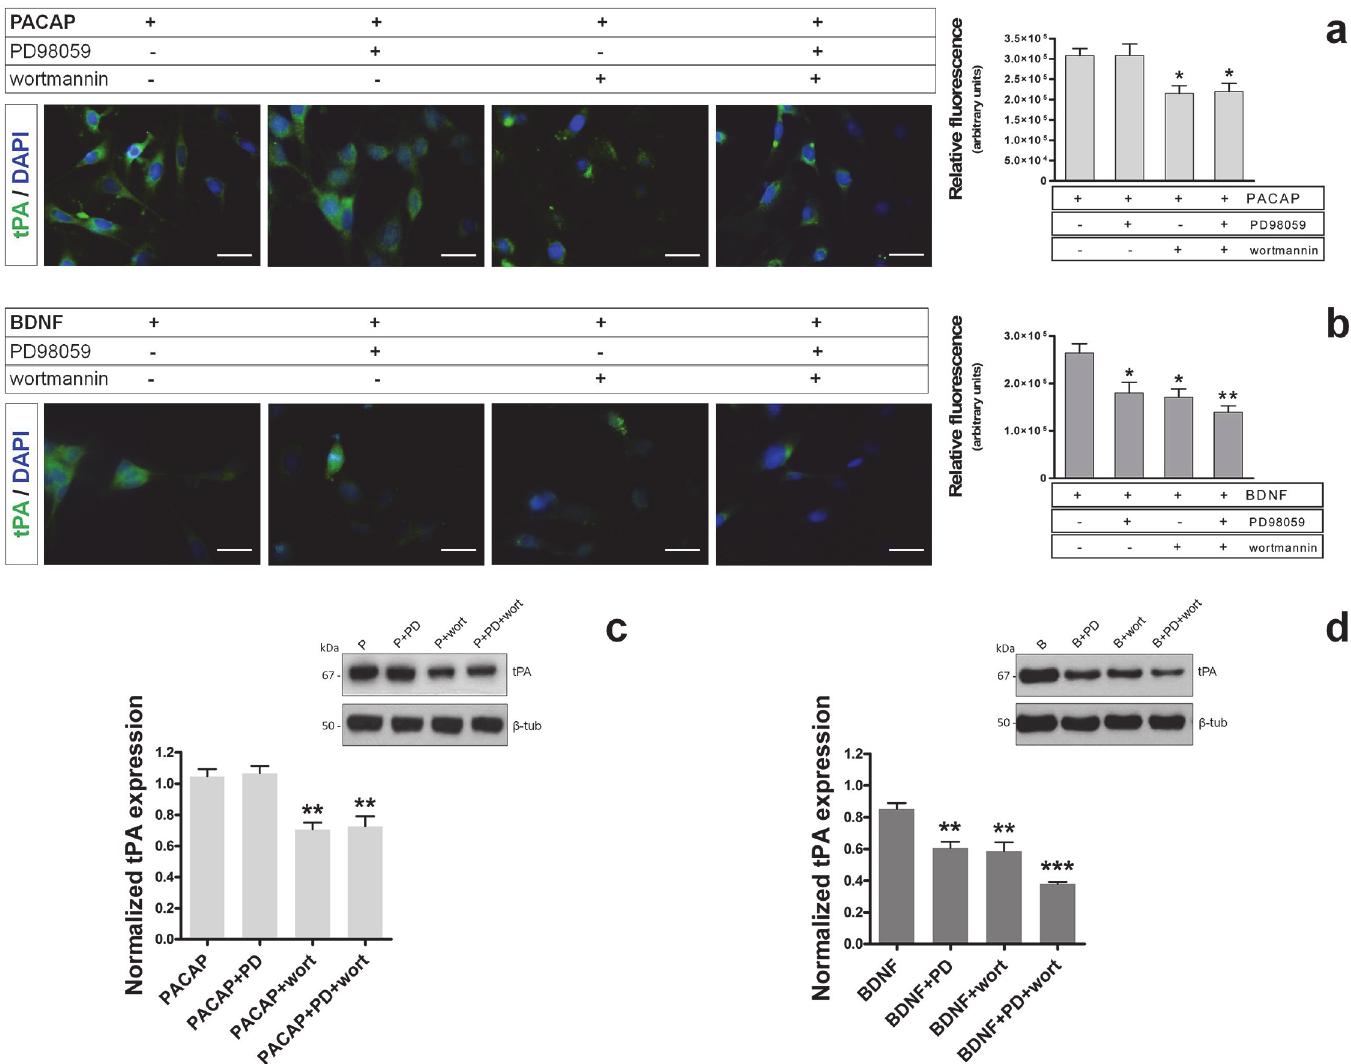
Fig. 4. Effects of MAPK Erk1/2 and PI3K inhibitors on tPA expression in RT4-D6P2T cells. Photomicrographs and relative quantifications of tPA-like immunoreactivity in RT4-D6P2T cells that were pretreated for 30 min with either 50 μ M PD98059 (a MEK1 inhibitor), 10 μ M wortmannin (a PI3K inhibitor) or a combination of both compounds and exposed to PACAP ( a ) or BDNF ( b ) for 24h. Immunofluorescent images were captured using an Axiovert 40 fluorescence microscope (Carl Zeiss Inc.). Each condition was reproduced in three dishes per experiment. Representative photomicrographs were taken from at least three fields per dish in a fixed pattern. Original magnification 40X. Scale bar = 30 μ m. For more details on the procedure please refer to MATERIALS AND METHODS section. Bar graph data is presented as the mean ± SEM. * p < 0.05 Vs Control ; ANOVA followed by Tukey post-hoc test. ( c and d ) Representative results from parallel immunoblot experiments showing the effect of pathway inhibitors on PACAP- or BDNF-mediated induction of tPA expression. Normalized expression levels were calculated using β -tubulin as the loading control. Each result displayed in the two bar graphs represents the mean ± SEM from three independent assessments ( c and d , respectively). ** p < 0.01 Vs Control ; ANOVA followed by Dunnett ’ s post-hoc